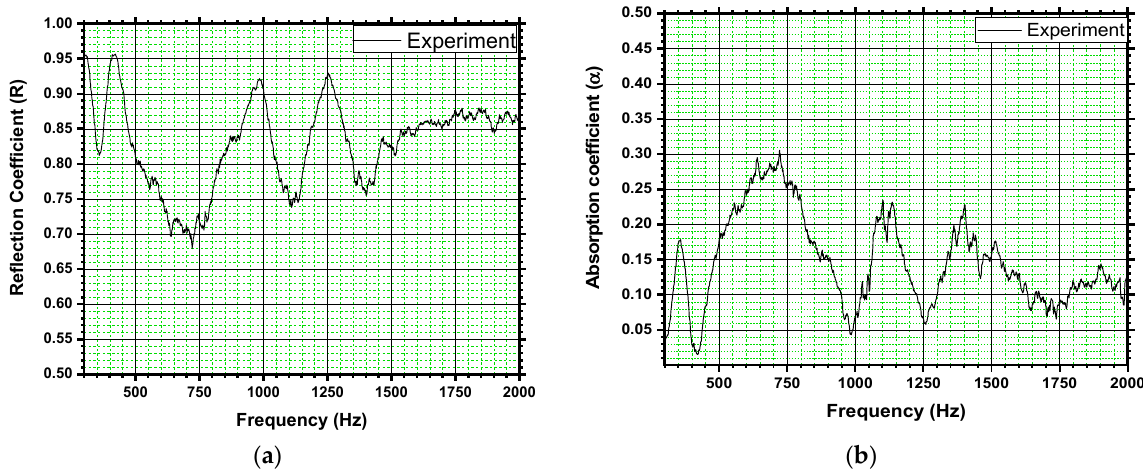
Figure 9. ( a ) Reflection coefficient vs. frequency ( b ) absorption coefficient vs. frequency .